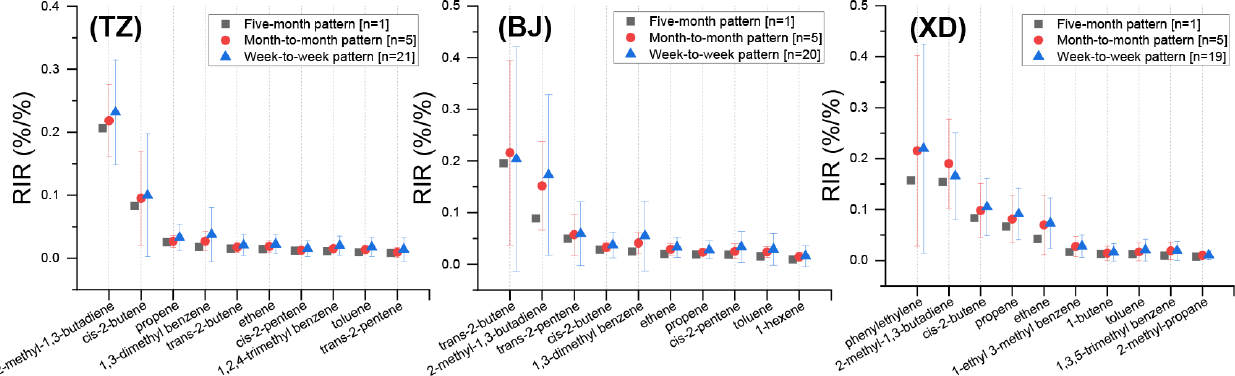
Figure 9. Averaged RIR values of individual AVOC species (top 10) at different patterns of timescale at three sites (TZ, BJ, and XD) in Zibo. The error bars represent the standard deviations of the